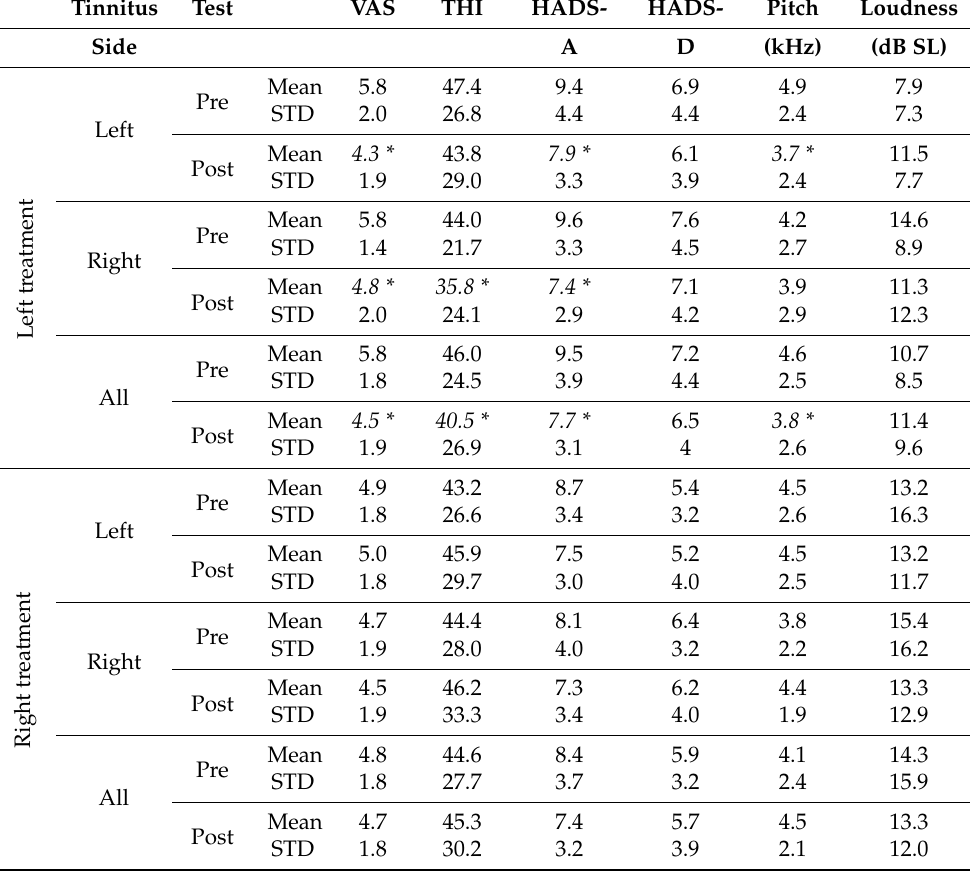
Table 2. Mean values and standard deviation for outcome measures for each tinnitus ear (“Left ear”, “Right ear”) and across tinnitus ears (“All”) within the Left, Bilateral, and Sham treatment groups. VAS = visual analog scale; THI = Tinnitus Handicap Index; HADS-A = Hospital Anxiety and Depression Scale Anxiety subscale; HADS-D = Hospital Anxiety and Depression Scale Depression subscale; kHz = kilohertz; dB SL = decibels sensation level; STD = standard deviation. Tinnitus Test VAS THI HADS-